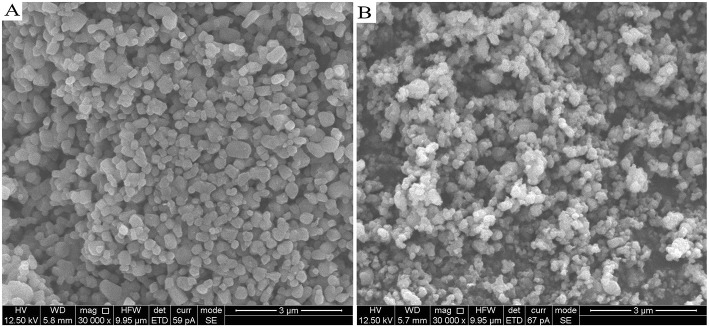
SEM pictures of Li4Ti5O12 and Li4Ti5O12@CN composite.